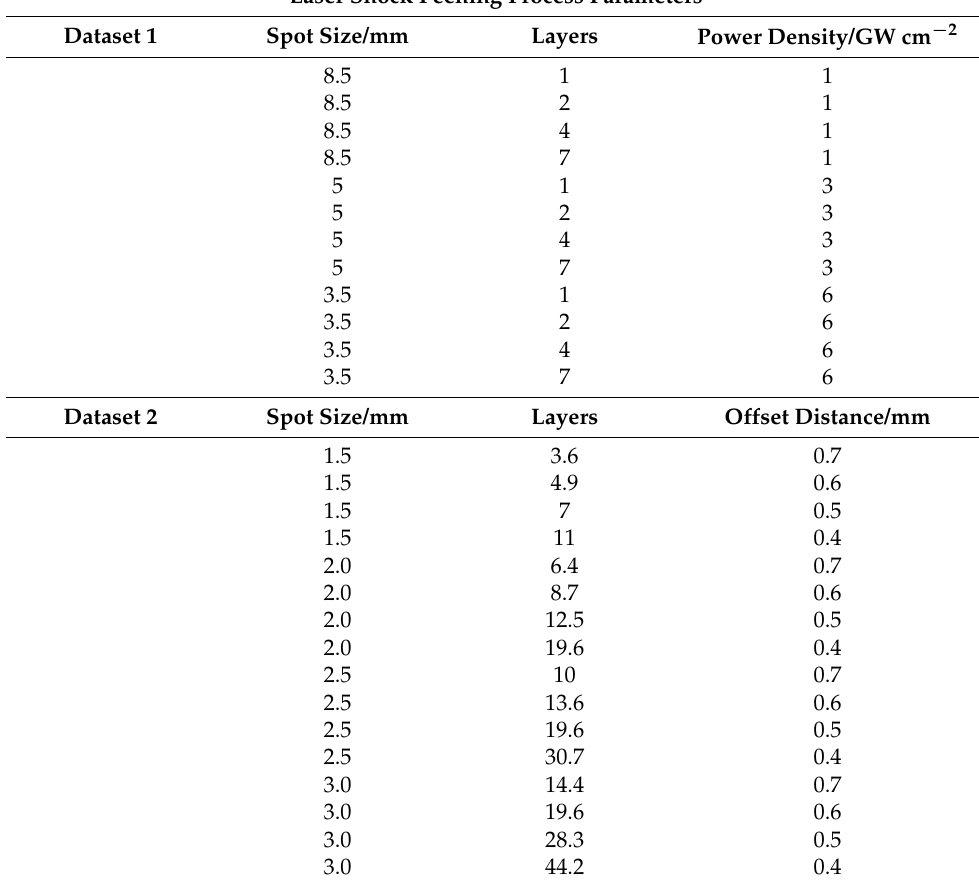
Table 2. Residual stress datasets using the incremental hole drilling method for training and testing the artificial neural network (ANN). Dataset 1 and 2 represent single-shot laser peening with square spots and multiple-shot laser peening with circular